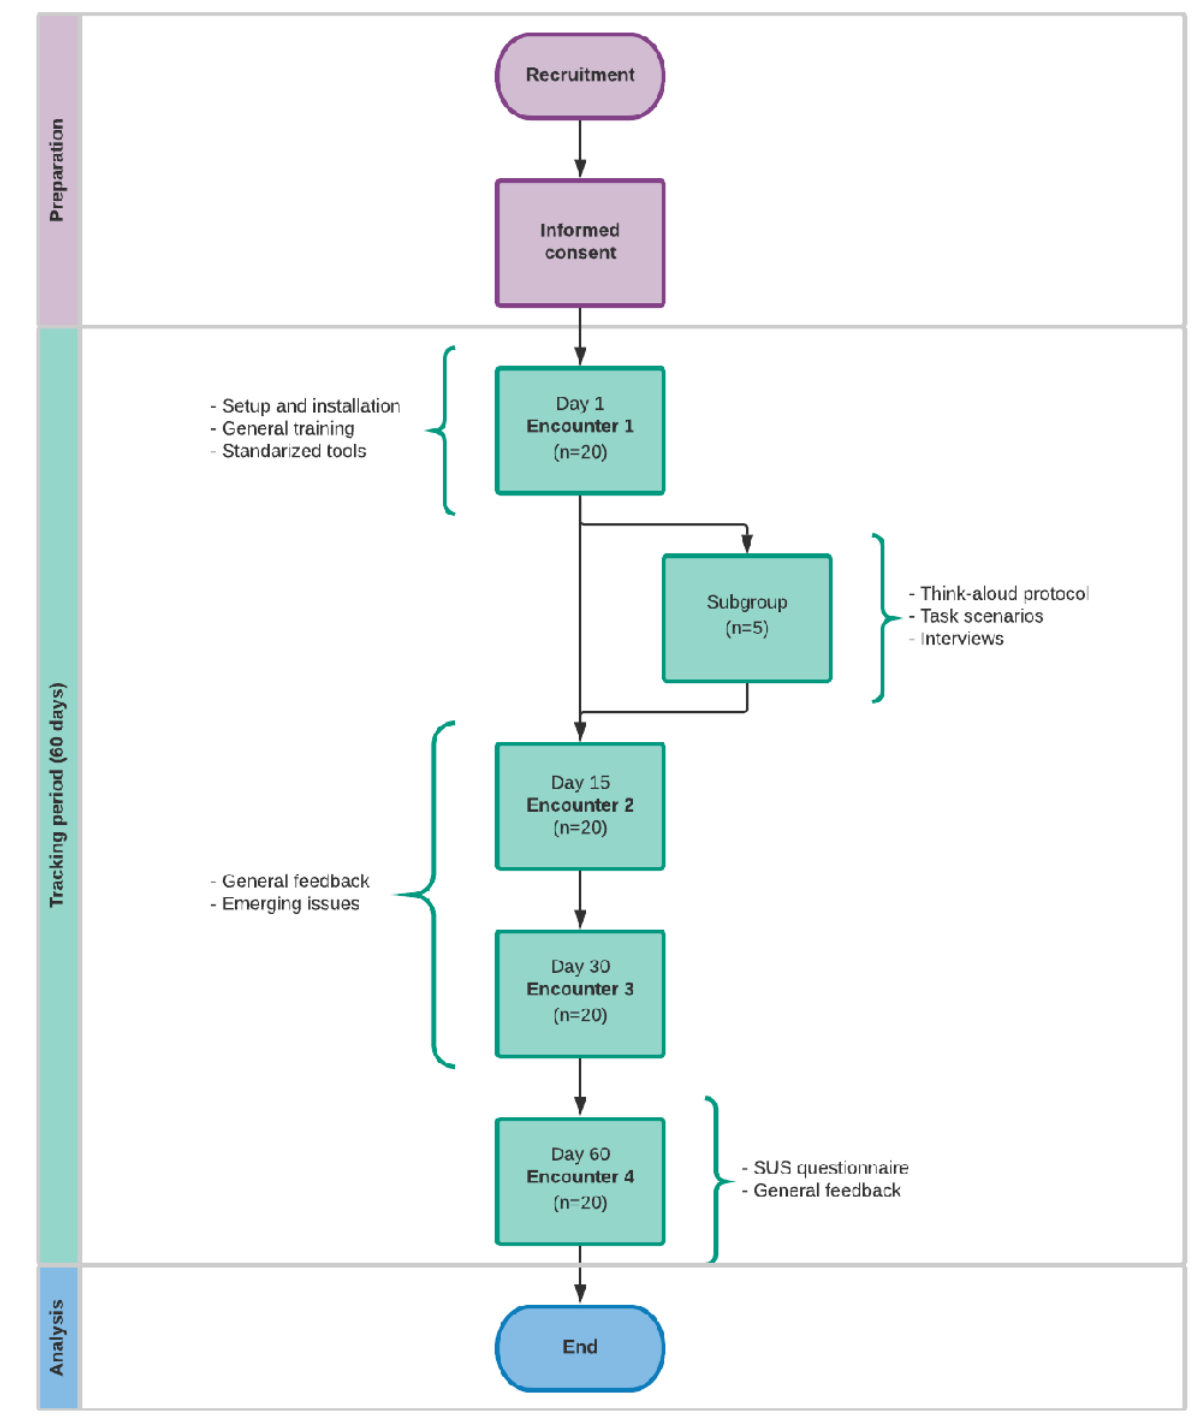
Figure 3. Study flow. SUS: System Usability